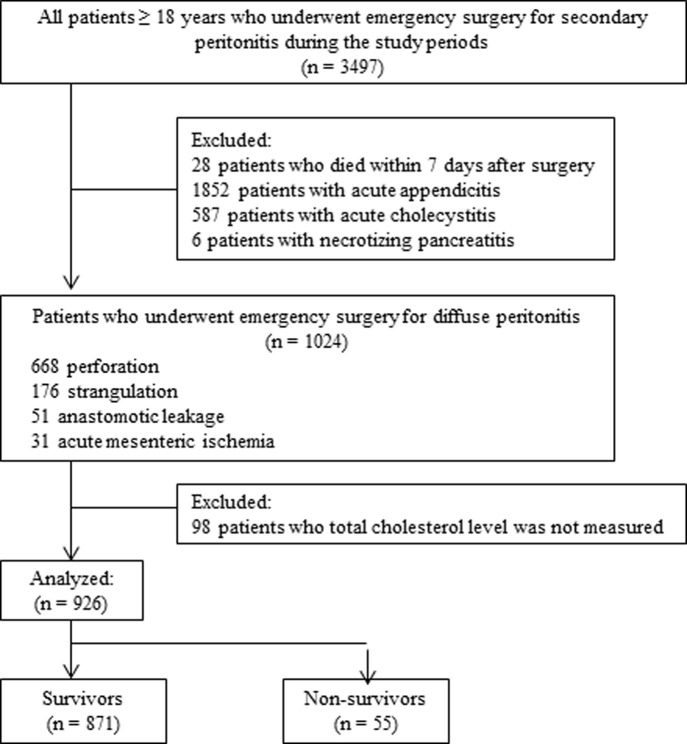
Flow diagram of the patient selection process.